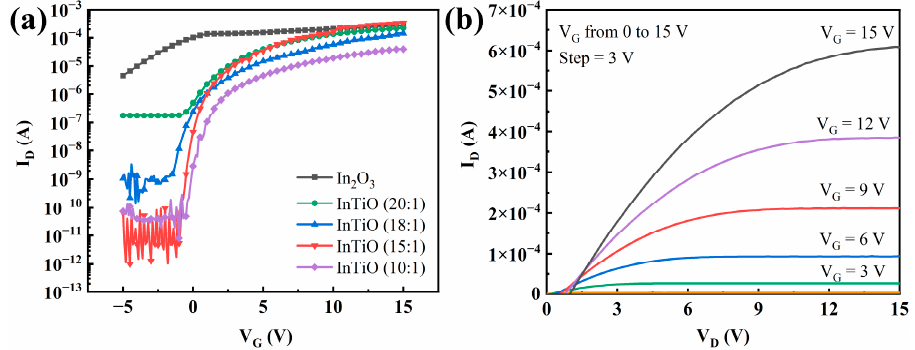
Figure 5. ( a ) Transfer characteristics ( V D = 5 V) of TFTs with various Ti 4+ doping concentrations. ( b ) Output characteristics of TFTs based on InTiO (15:1).